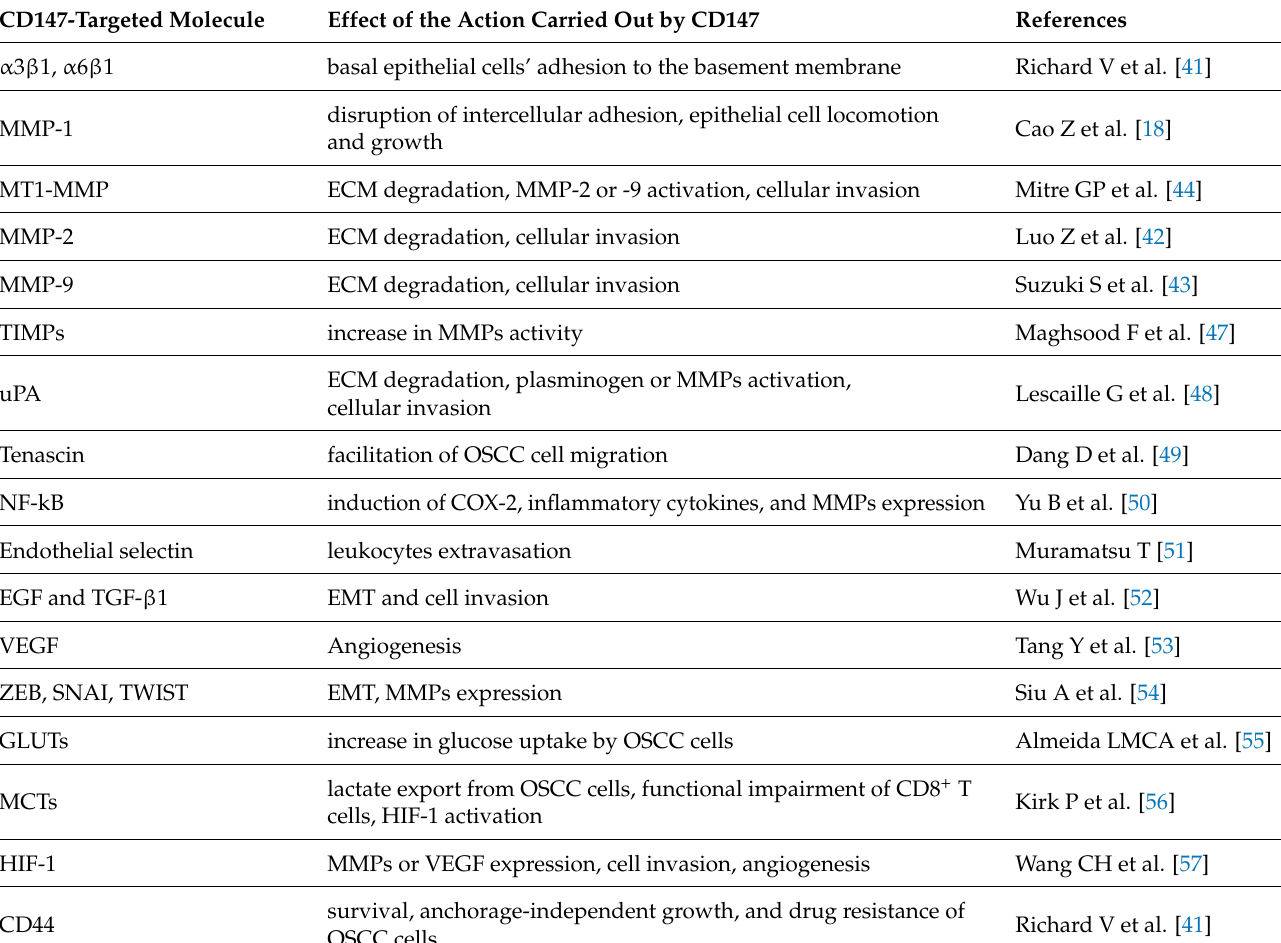
Table 2. CD147 modulates the expression or function of transcriptional activators, cytokines, and proteolytic enzymes with a role in the development and/or progression of